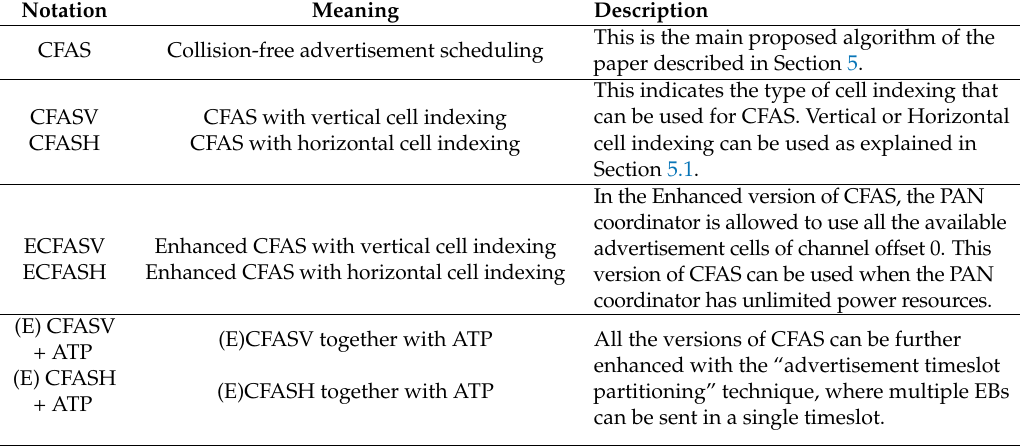
Table 3. Notations and descriptions for the different versions of collision-free advertisement scheduling